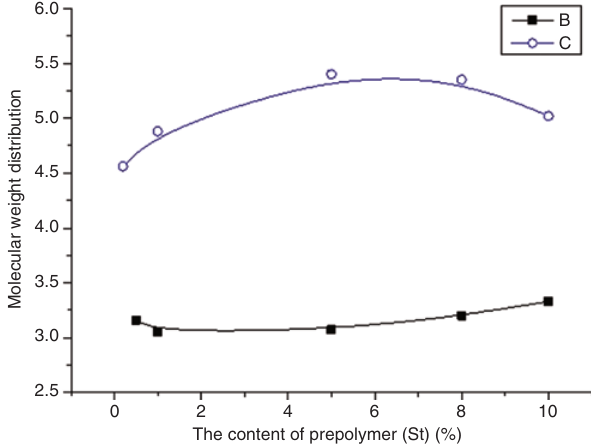
Figure 7: The relationship between molecular weight distribu- tion and the concentration of prepolymer (St). Curve B – sample without adding α -hydroxylethyl ferrocene, curve C – sample adding a-hydroxylethyl ferrocene.